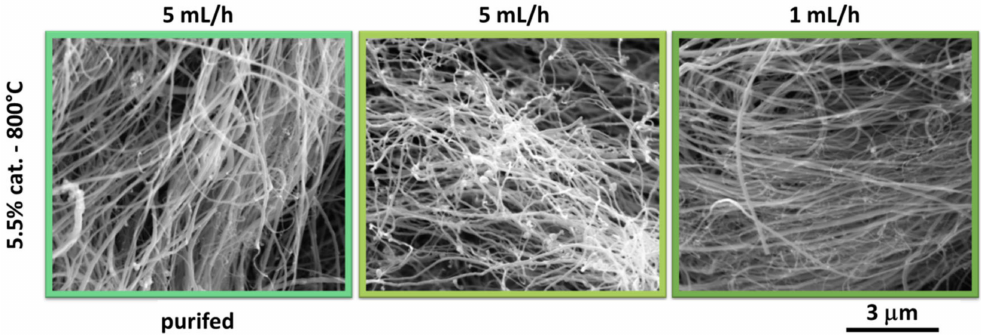
Figure 5. SEM micrographs of MWCNTs obtained at 800 ◦ C and with 5.5% cat. Material purified by acid treatment has been shown on the left. Moreover, the impact of lowered injection rate (from 5 mL / h to 1mL / h) of precursor mixture has been given on the